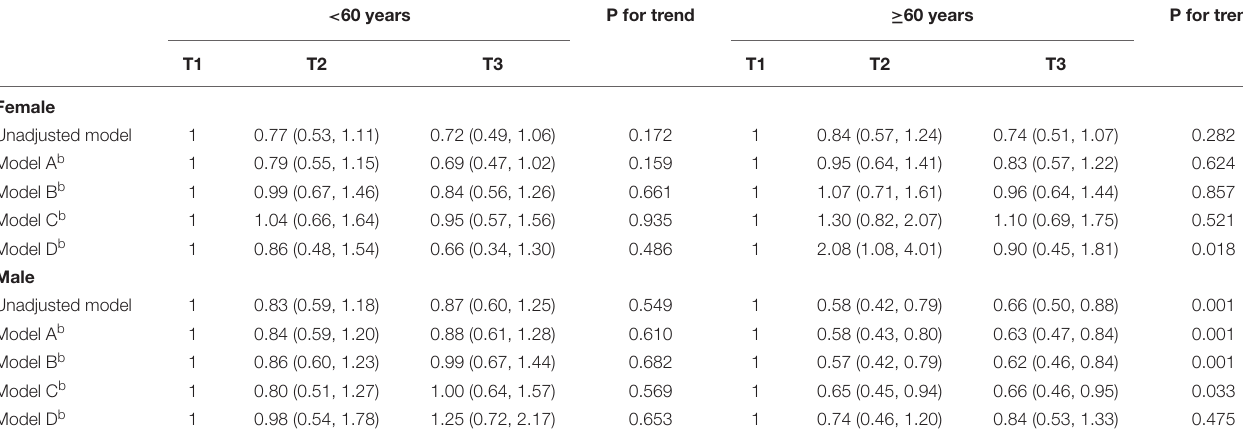
TABLE 2 | Association between fat mass to lean body mass ratio and all-cause mortality using Cox proportional hazard regression. a